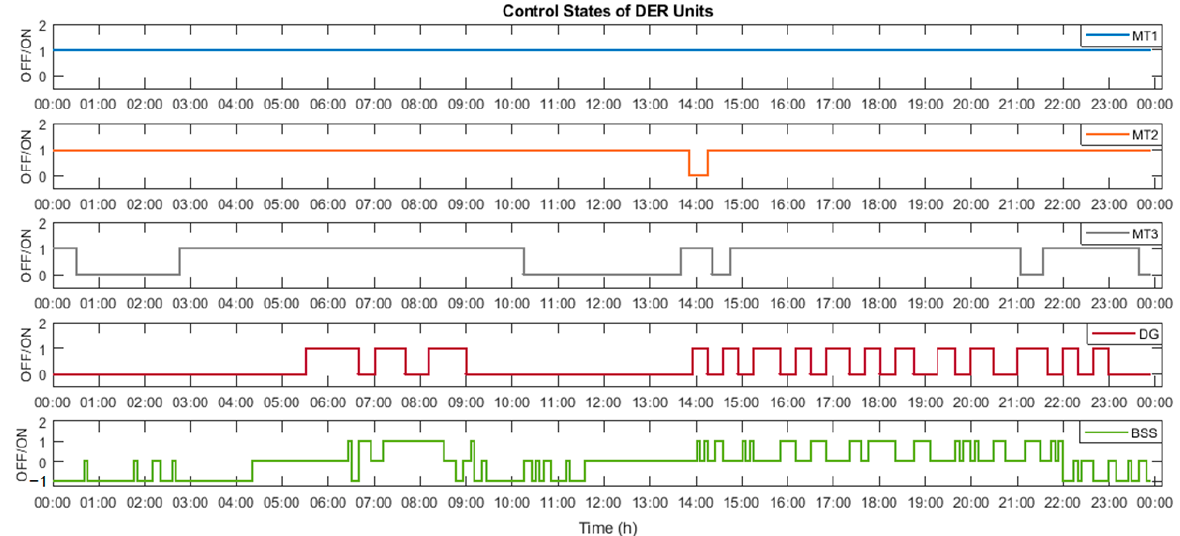
Figure 10. Simulation outcome for 69-bus system: control states for DER units.